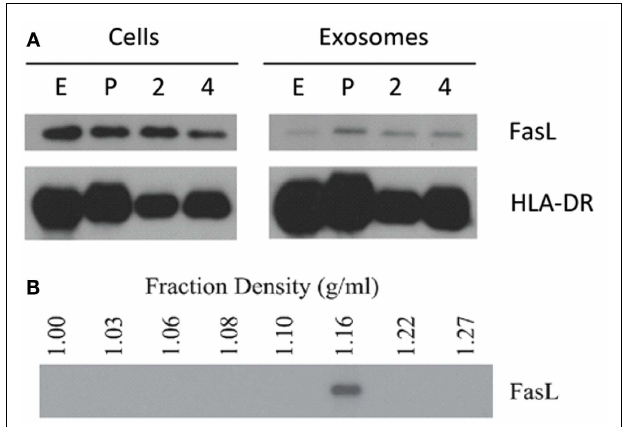
FIGURE 2 | LCL secrete exosomes containing FasL and MHC class II. (A) Cell lysates and spontaneously secreted exosomes were collected from four LCL (lines E, P, 2, and 4) and probed for the presence of FasL and HLA-DR by immunoblot. (B) Exosomes from a representative LCL were floated onto a discontinuous density gradient of iodixanol solution and spun for 1h at 100,000 × g . Individual layers were removed and diluted with PBS, followed by an overnight centrifugation at 100,000 × g .The resulting pellets were lysed with SDS buffer and probed for FasL by